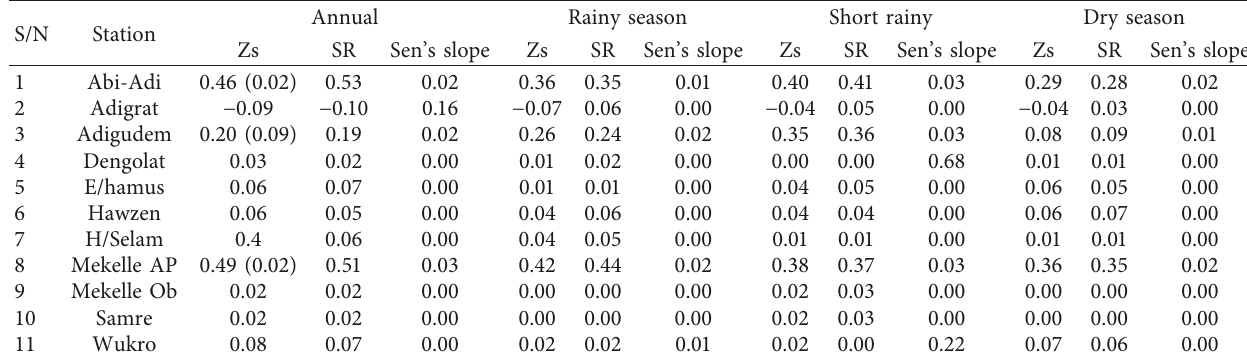
Table 5: Summary of temperature trend test using Mann–Kendall and Sen’s slope.